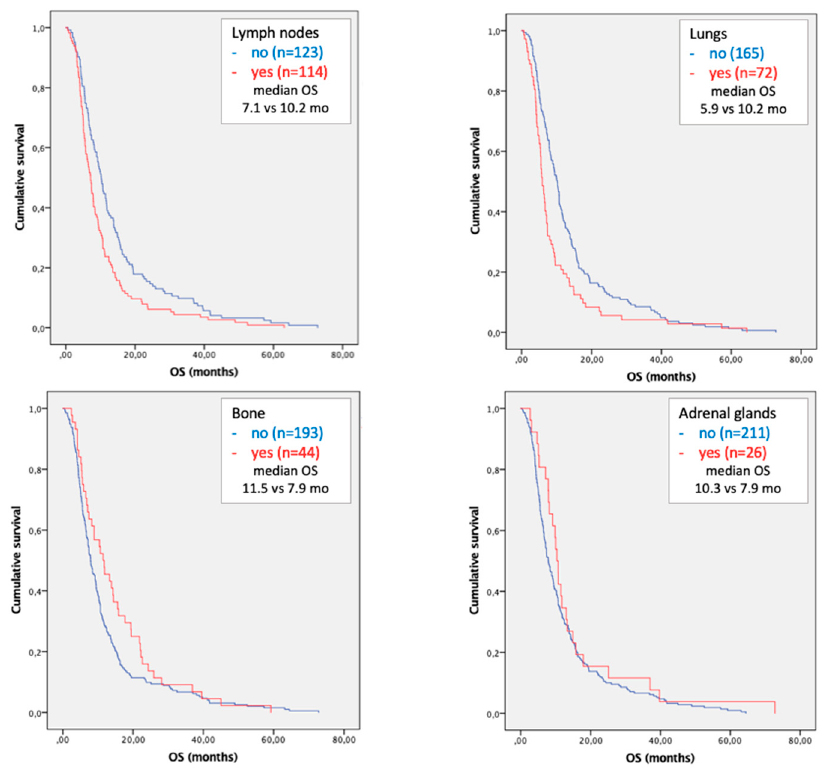
Figure 2. Kaplan–Meier curves of overall survival in patients with lymph node, lung, bone and adrenal gland metastases. Table 4. Univariate and multivariate Cox regression analysis of overall survival in the cohort of patients with a single site of